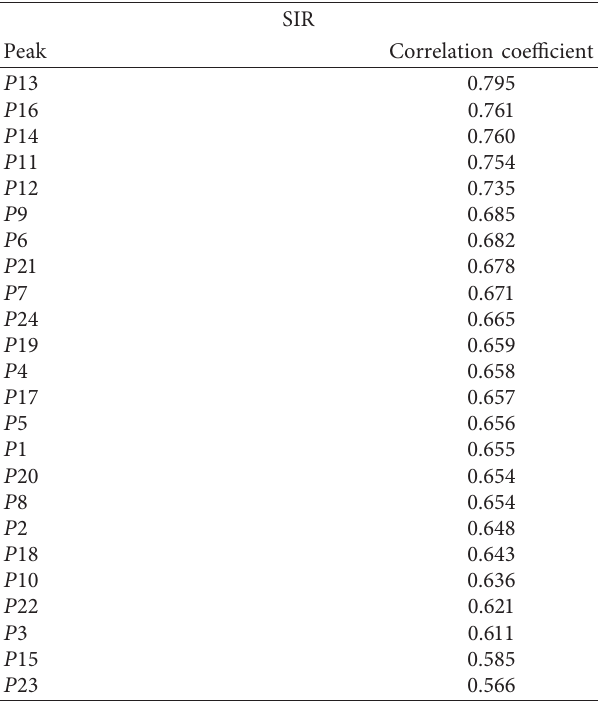
Table 3: Coefficient of correlation of Qing Jin Hua Tan Tang components with their pharmacodynamics (swell inhibition rate